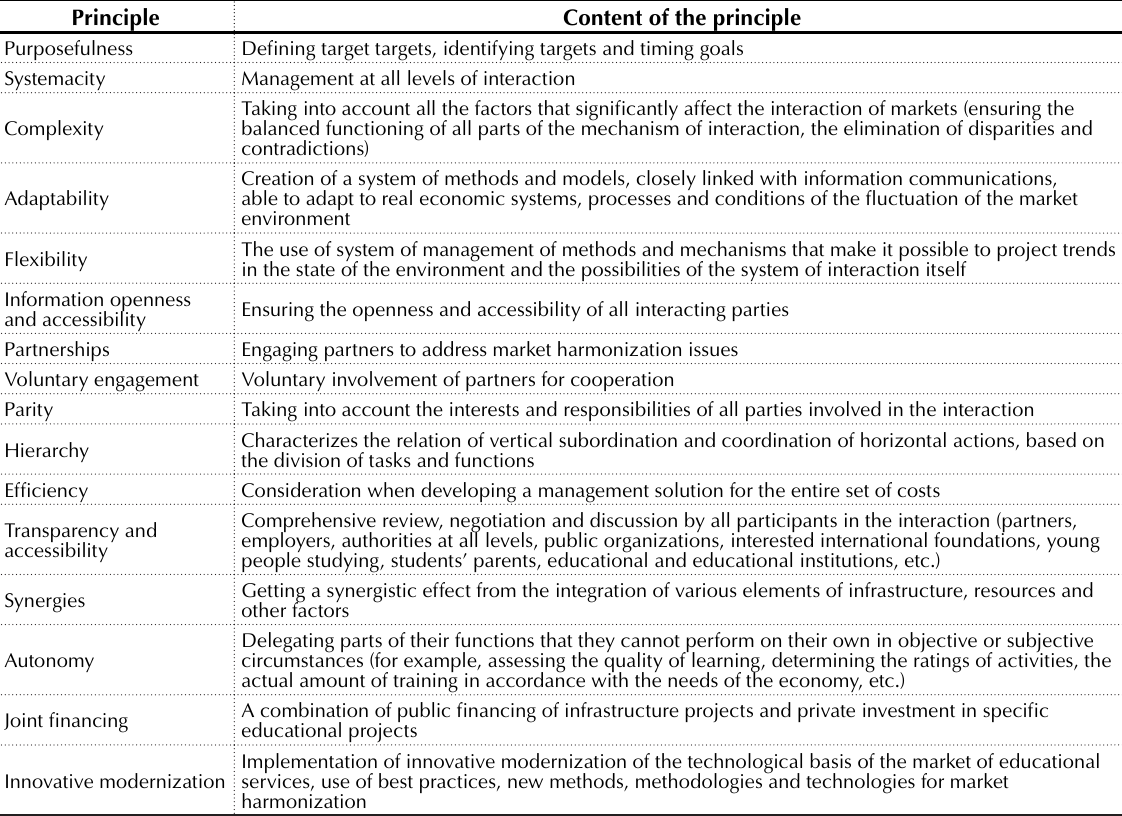
Table 1. Principles of the interaction of IHE and